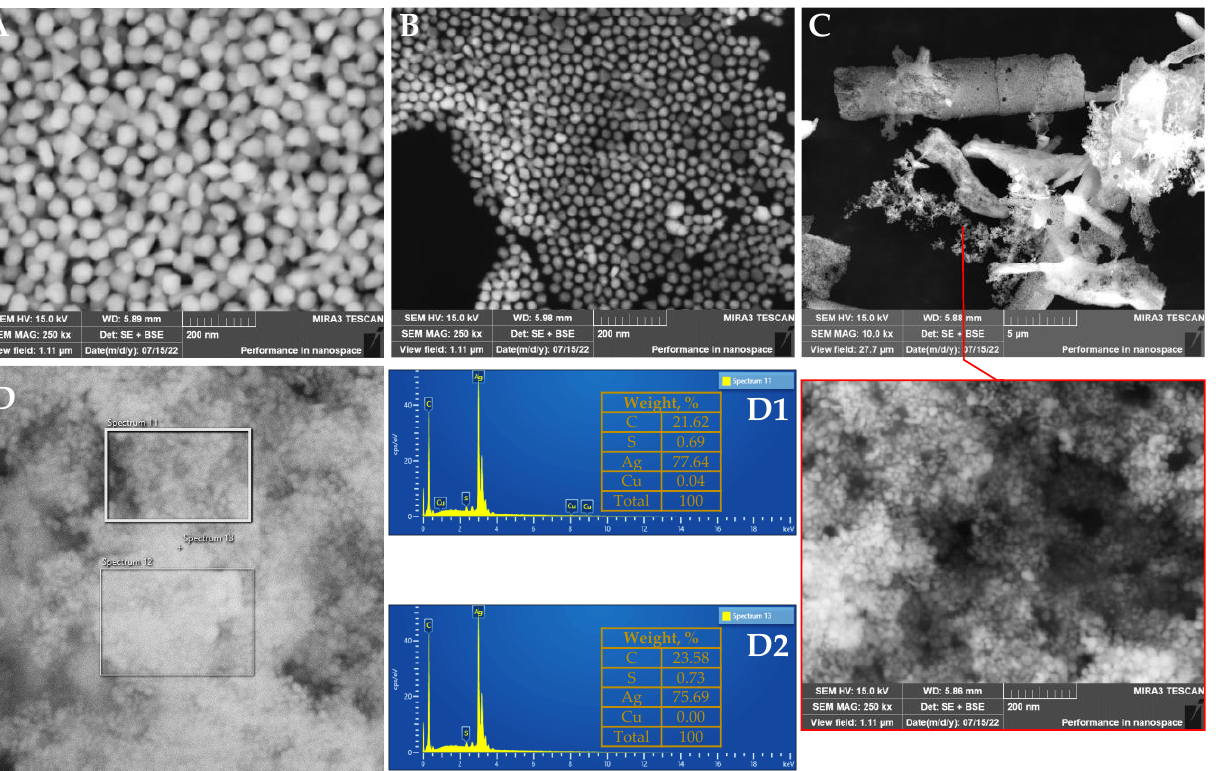
Figure 7. Disk diffusion tests for silver nanoparticles obtained using both synthetic and rye bran- derived trans -ferulic acid against Bacillus subtilis ATCC6633 ( A ), Escherichia coli ATCC25922 ( B ), En- terococcus faecium ATCC29212 ( C ), Staphylococcus aureus ATCC65388/NCTC7447 ( D ), and Pseudomo- nas aeruginosa ATCC10145 ( E ). The zone of inhibition is highlighted with a dashed red circle indi- cating a noticeable antibacterial effect. FA-ST-AgNPs — silver nanoparticles produced by synthetic trans -ferulic acid; FA-RB — a mixture of trans -ferulic acid and trans - iso -ferulic acids recovered from rye bran after enzymatic hydrolysis with multi-enzyme complex Viscozyme L; FA-RB-AgNPs — sil- ver nanoparticles produced by biosynthetic trans -ferulic and trans - iso -ferulic recovered from rye bran after enzymatic hydrolysis with multi-enzyme complex Viscozyme L; FA-ST — synthetic trans- ferulic acid.